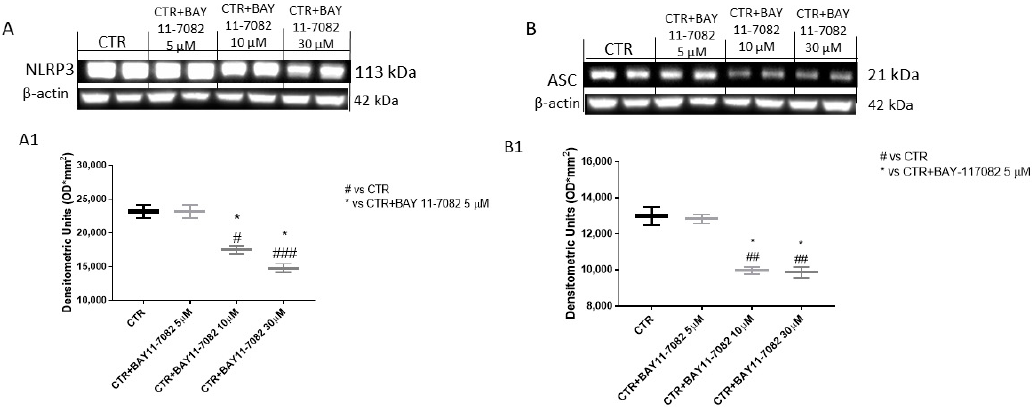
Figure 2. Effect of BAY-117082 on NLRP3 inflammasome and ASC expression. Blots reveal that treatment with BAY-117082 at concentrations of 10 and 30 µM was able to reduce NLRP3 and ASC expression compared to control group. Data are representative of at least three independent experiments. ( A ) # p < 0.05 vs. CTR; ### p < 0.001 vs. CTR; * p < 0.05 vs. CTR + BAY-117082 10 µ M. ( B ) ## p < 0.01 vs. CTR; * p < 0.05 vs. CTR + BAY-117082 10 µ M.